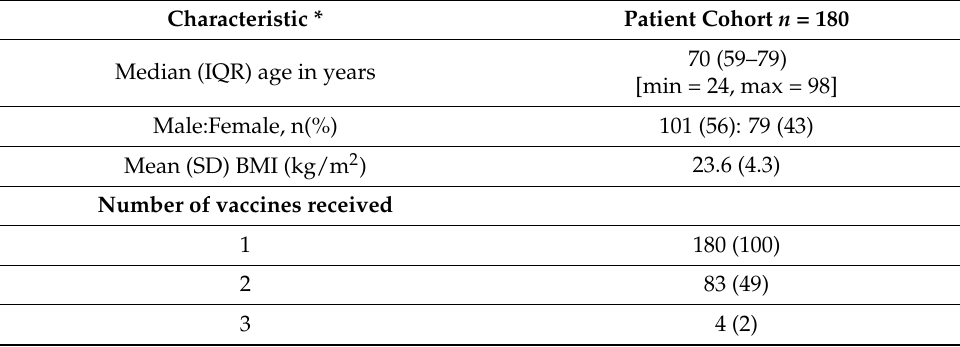
Table 1. Baseline characteristics of the